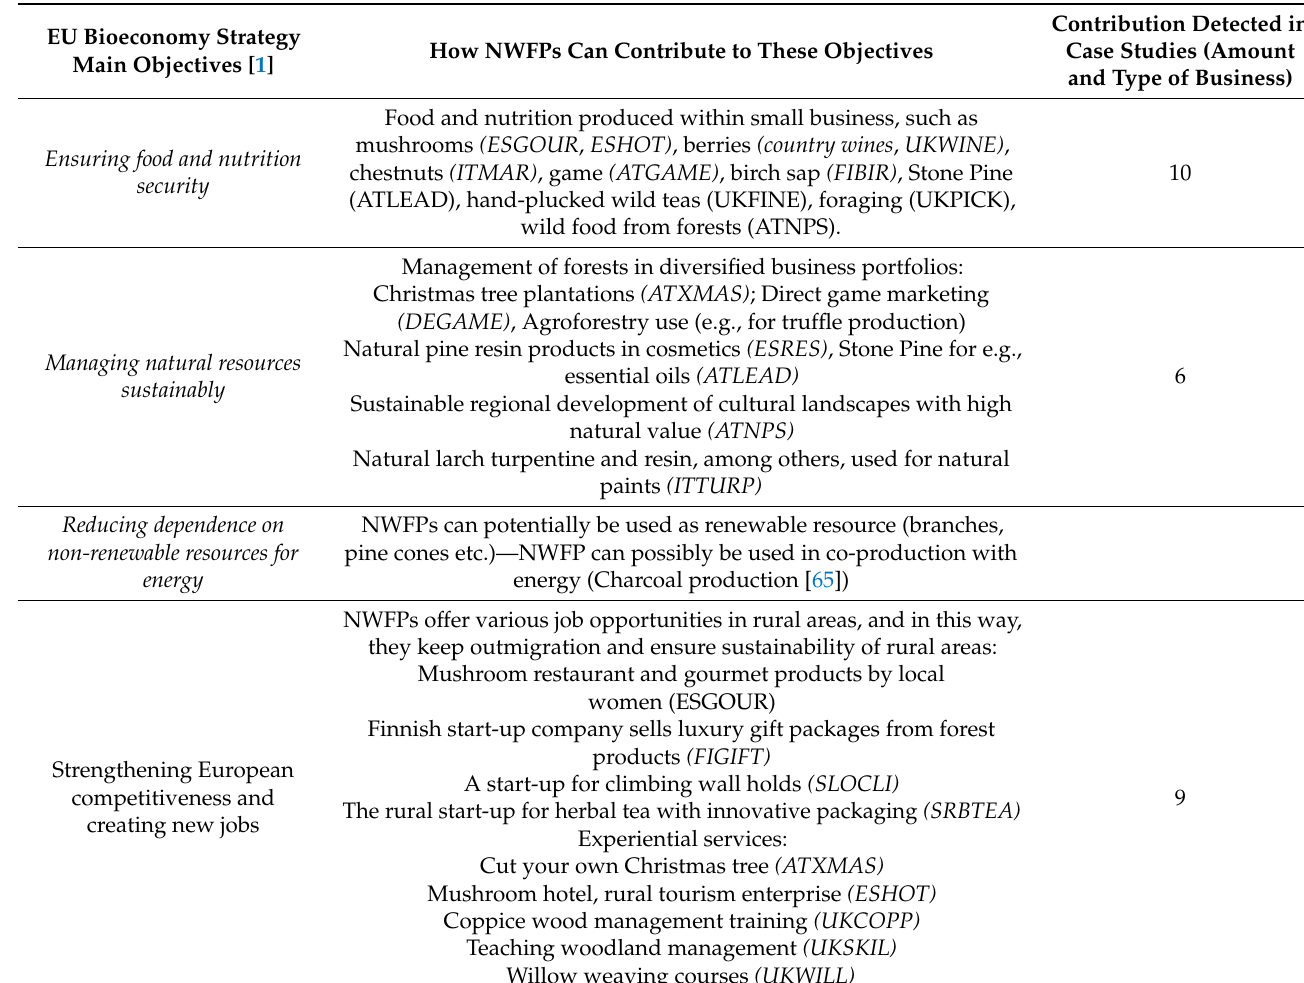
Table 5. NWFPs potential contribution to EU Bioeconomy Strategy main